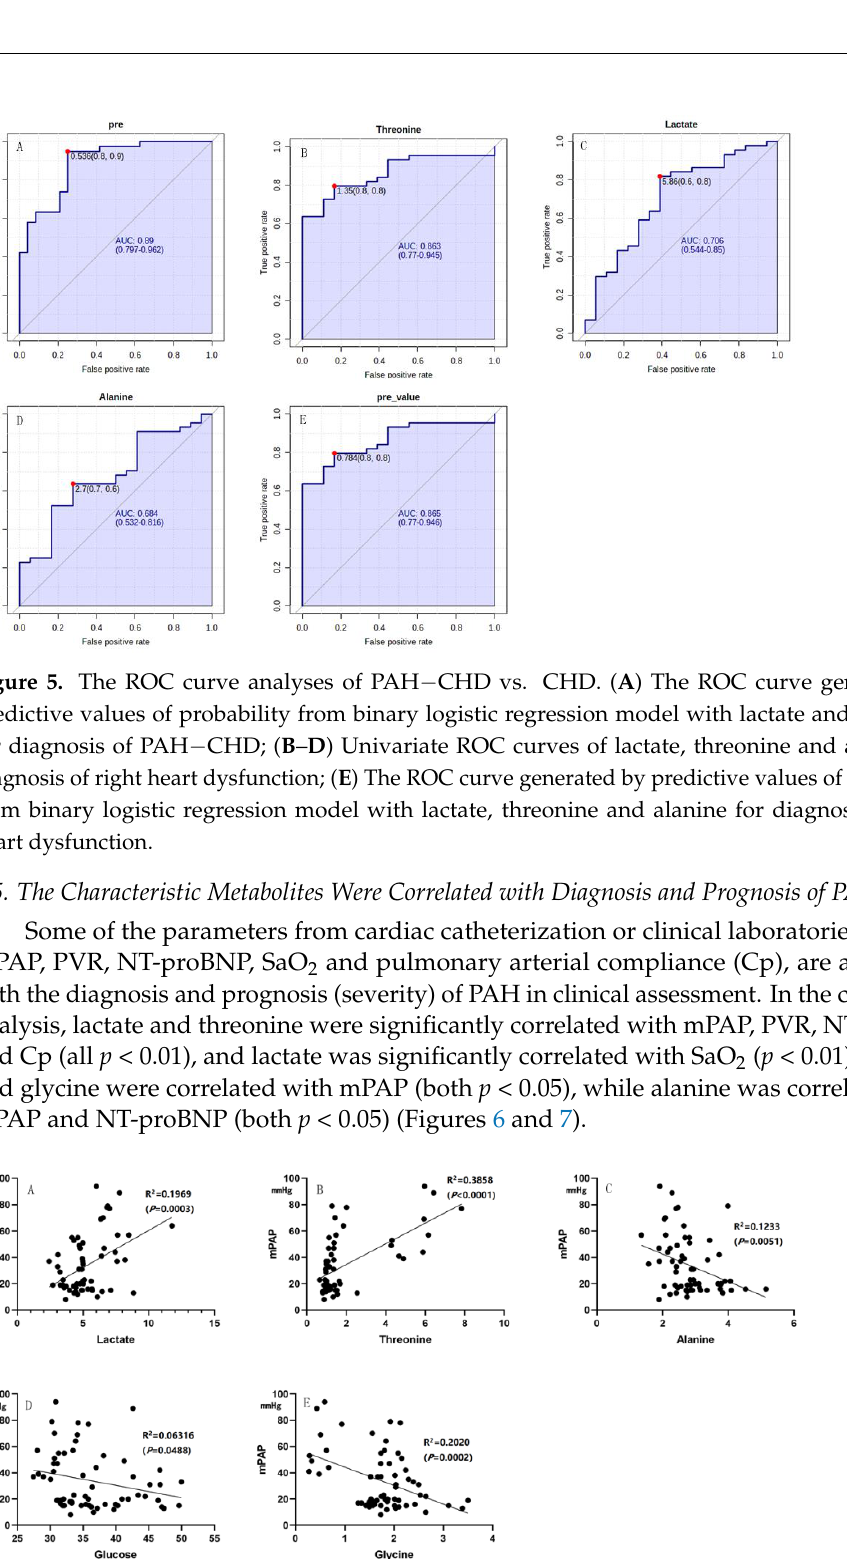
Figure 7. Correlation analysis. ( A , B ) Lactate and threonine were positively correlated with PVR; ( C – E ) Lactate and threonine were positively correlated with NT − proBNP, while alanine was negatively correlated with NT − proBNP; ( F , G ) Lactate and threonine were negatively correlated with Cp; ( H ) Lactate was negatively correlated with SaO 2 . 4. Discussion The present study is an extension of metabolic profiling of PAH using NMR-based metabolomic technique s . The metabolic features of PAH-CHD were revealed by the metabolomic analysis of plasma from 24 adult patients with definite PAH and large non- restrictive defects, whose pulmonary vasculature had been persistently exposed to in- creased PBF since their births. This represents the first study to our knowledge to illustrate the metabolic alterations of a specific PAH cohort including adult patients with left-to- right shunt using NMR-based metabolomic analysis. We also reported a group of metab- olites that could be used as potential biomarkers for noninvasively distinguishing PAH- CHD from CHD, assessing its severity and predicting its outcome. Although we realize precisely that the increased PBF can cause proliferation and met- abolic alterations of PASMCs in CHD models [2,6], the global metabolism of patients with CHD remains obscure. In our cohort, the CHD patients without PAH were observed with promoted metabolisms including energy metabolism and anabolism to meet the demands of pulmonary vascular cell proliferation and right ventricular overload. After the